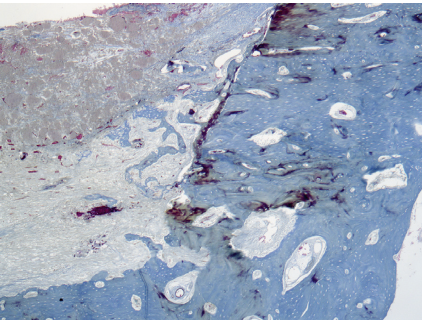
Figure 10: Histological picture of the cross section of the mandible of the rabbit 4 weeks after the formation of a bone defect and introduction of calcium hydroxide suspension.